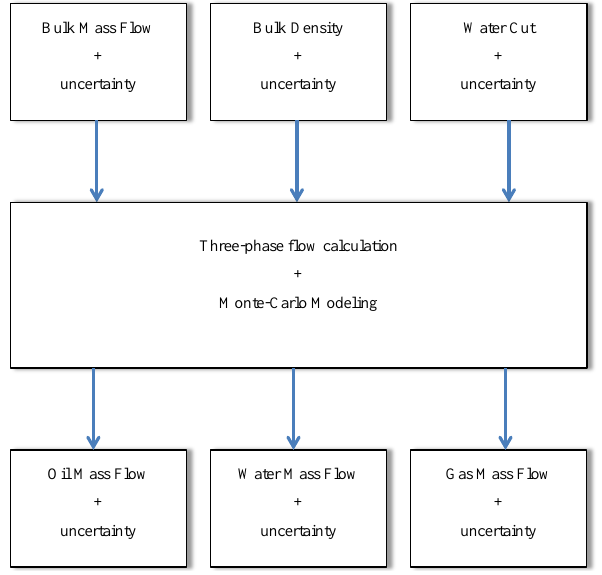
Figure 8. Monte Carlo modelling to estimate output